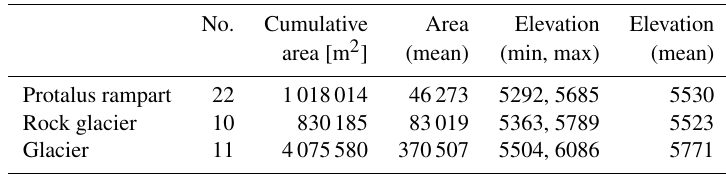
Table 2. Statistical description of cryotic landforms based on DEM analyses.